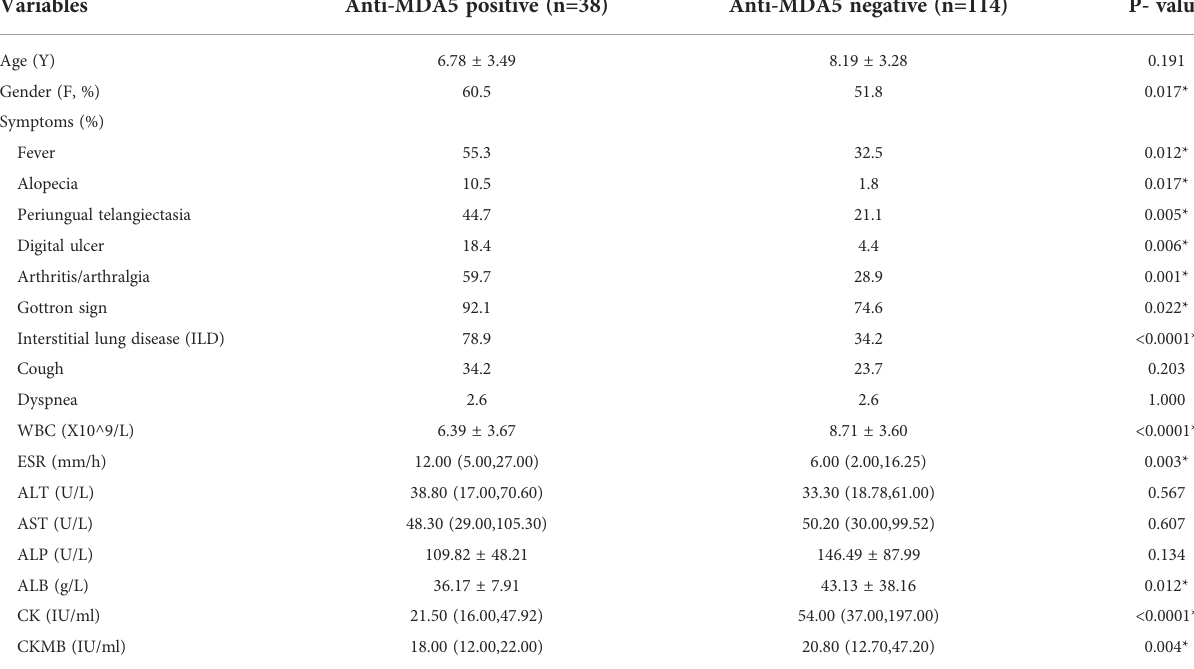
TABLE 1 19 candidate variables including the demographic and clinical characteristics of the participants analyzed for the risk of anti-MDA5 (anti-melanoma differentiation associated gene